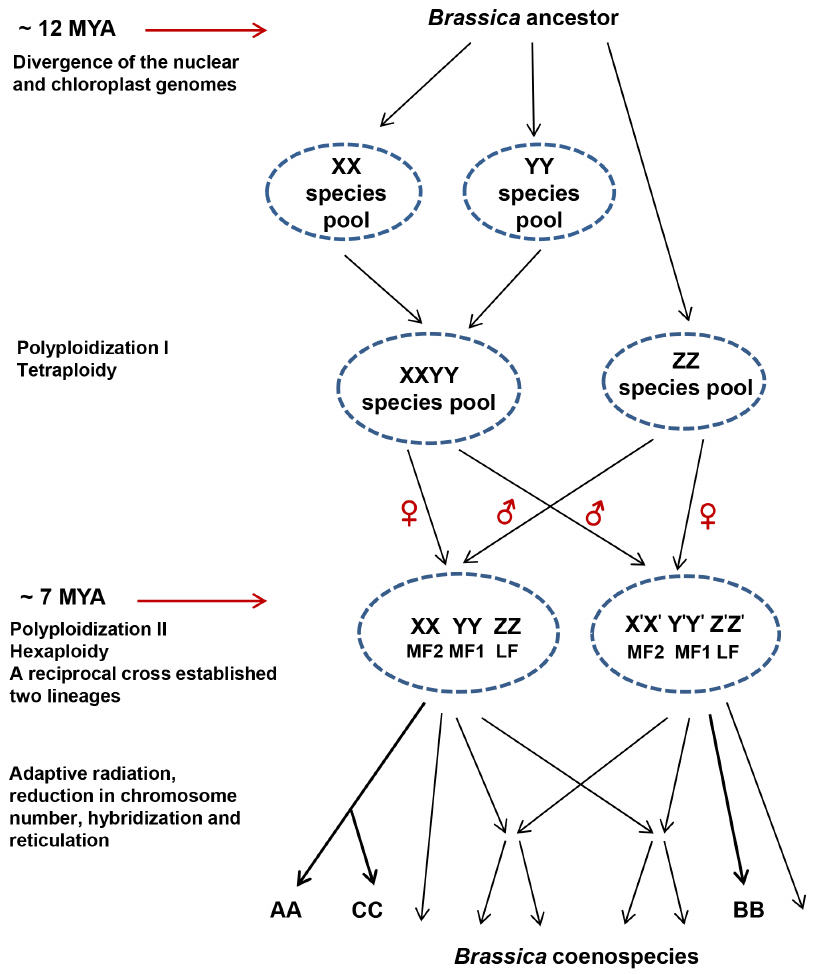
Figure 3. A model depicting the evolutionary events leading to divergence of the Rapa/Oleracea and Nigra lineages of Brassiceae. Length of the arrows does not represent evolutionary distance.